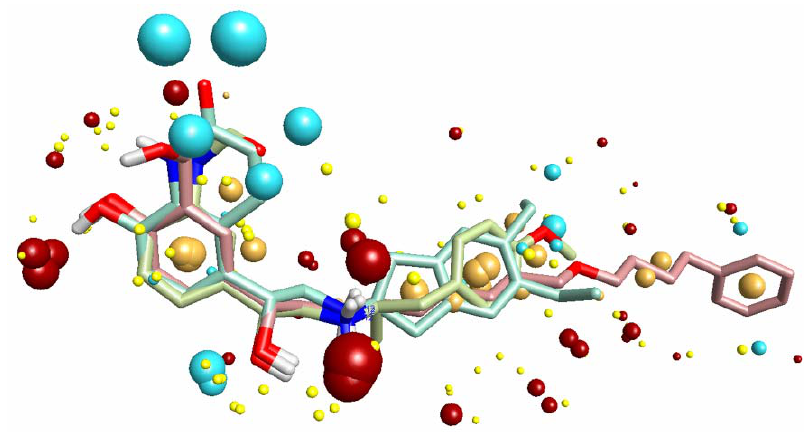
Figure 4. Field point patterns of the three conformers of arformoterol, salmeterol and indacaterol in Template T1. Field points are color coded as follows: negative charge, blue; positive charge, red; van der Waal’s surface, yellow; hydrophobes, orange.